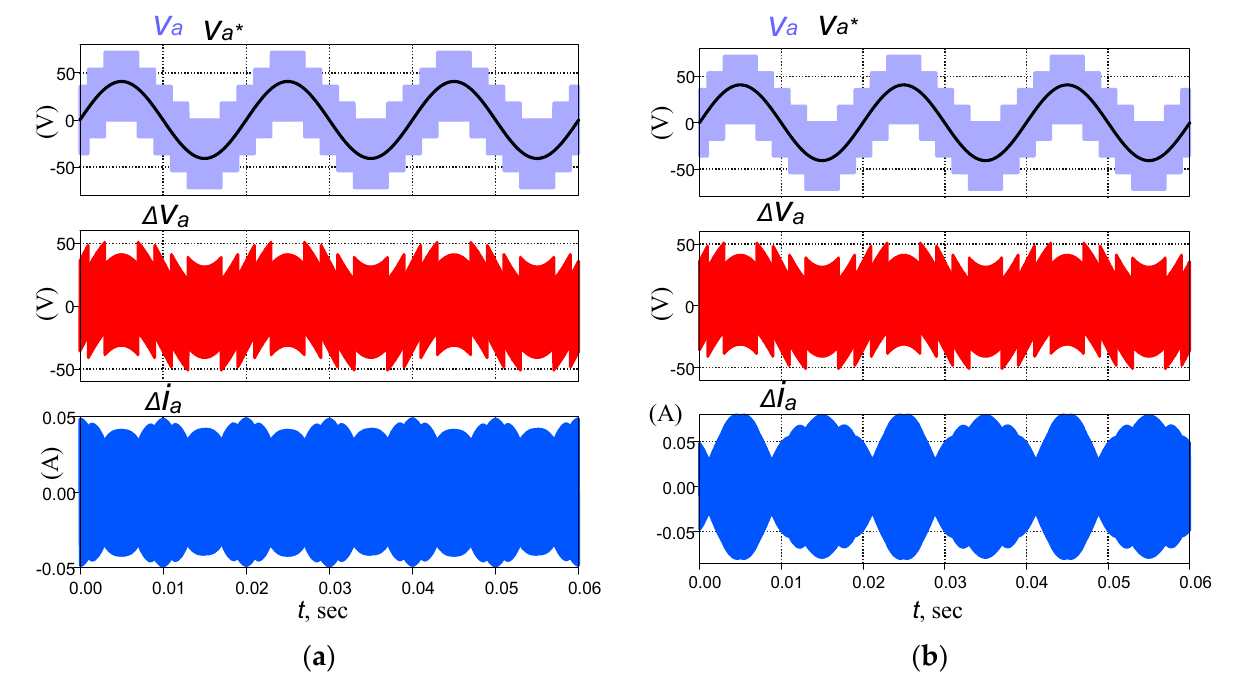
Figure 19. The simulation waveform of output-phase voltage, error voltage, and the corresponding current ripples for both VSI and SSI topologies. ( a ) Boost-converter followed by five-phase VSI. ( b ) Proposed five-phase SSI.